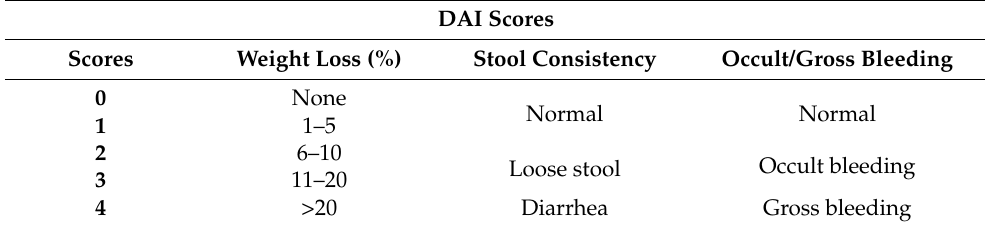
Table 1. Criteria used for disease activity index (DAI)